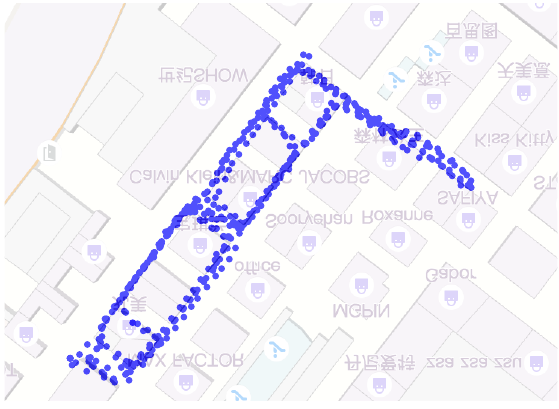
Figure 12. The interpolated positions where fingerprints are